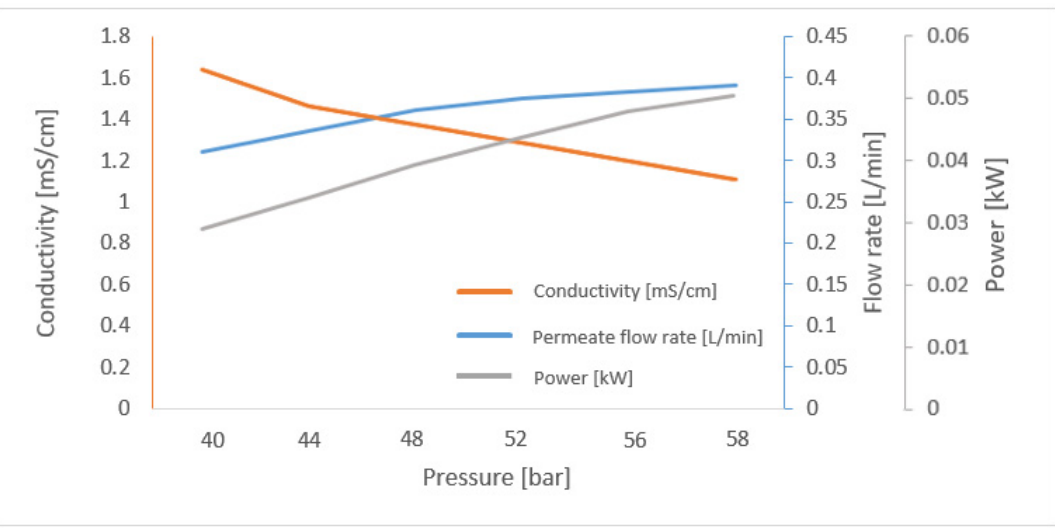
Figure 8. Pressure versus conductivity, permeate flow rate, and power.